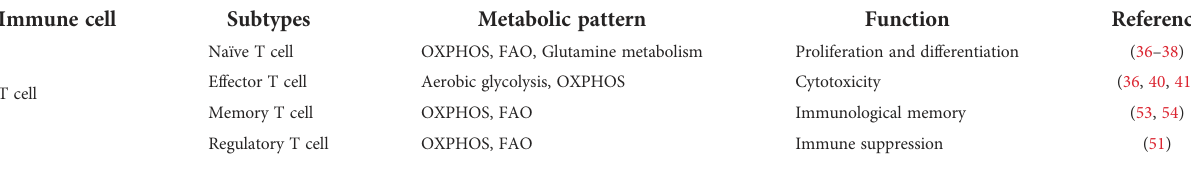
TABLE 1 An overview of metabolic characteristics of different T cell populations. Immune